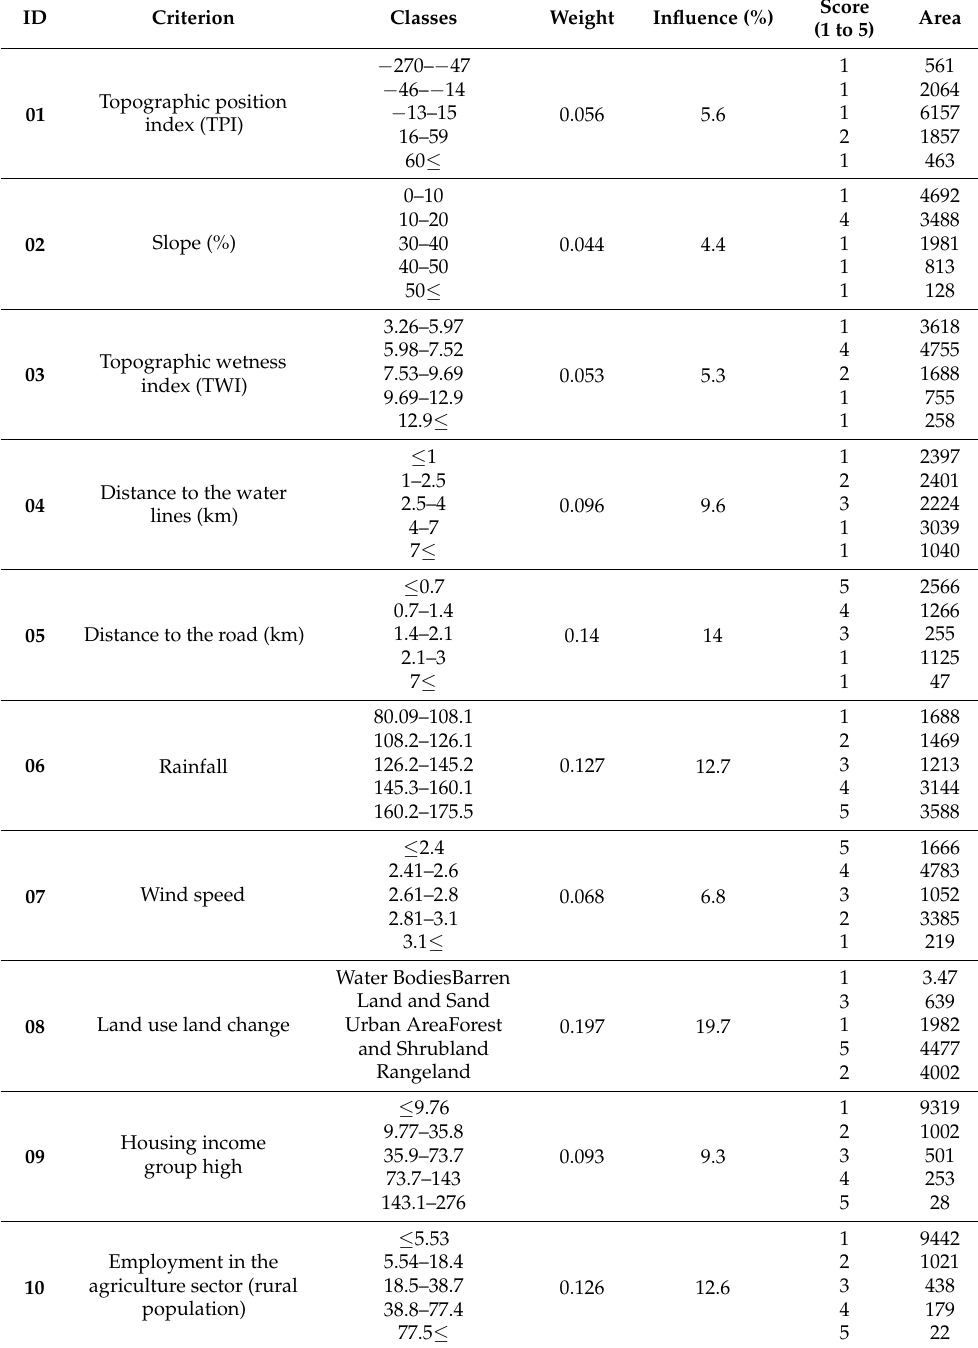
Table 8. Characteristic of the main criteria and sub-criteria used for GI